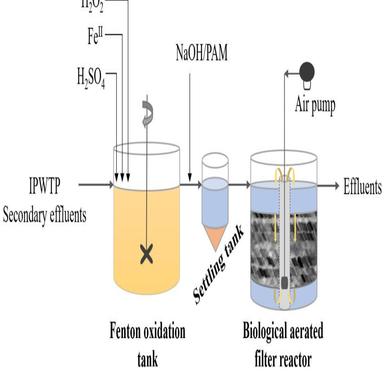
Schematic diagram of Fenton oxidation process combining with the BAF reactor for advanced treatment of IPWTP secondary effluents.